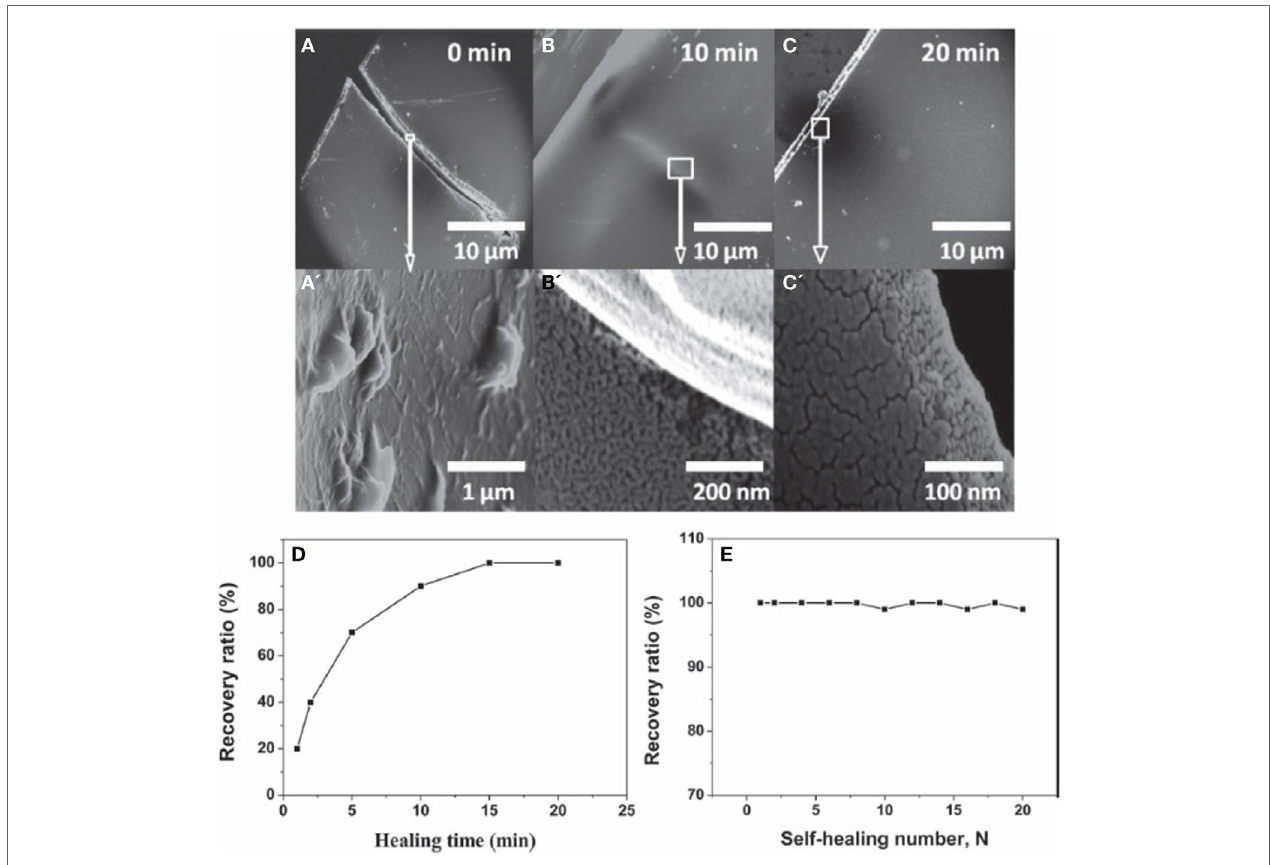
FiGURe 16 | SeM image of G-PAM-PAA strip heating at 37°C in different times, (A) 0 min, (B) 10 min, and (C) 20 min. (A ′ –C ′ ) are close-up view of the factures occurred in (A–C) , respectively. Percentage of the recovery ratio as a function of (D) healing-time and (e) self-healing number (N). Reproduced with permission from Dong et al. (2013). Copyright 2013,